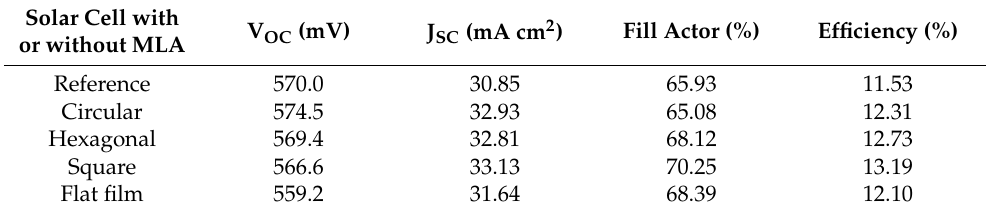
Figure 8. ( A ) The I-V curves and ( B ) the P-V curves of silicon solar cells with flat film, circular, hexagonal, and square MLAs films compared with the silicon solar cells without photoresist film MLAs. Table 2. Specific parameters of silicon solar cells with different shapes of Table 2. Specific parameters of silicon solar cells with different shapes of MLAs.